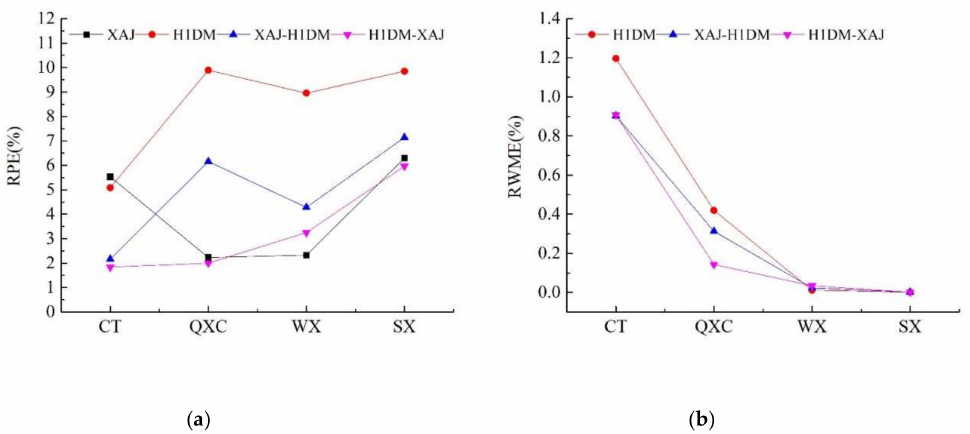
Figure 9. Average RPE ( a ) and RWME ( b ) of the four sites during all periods.